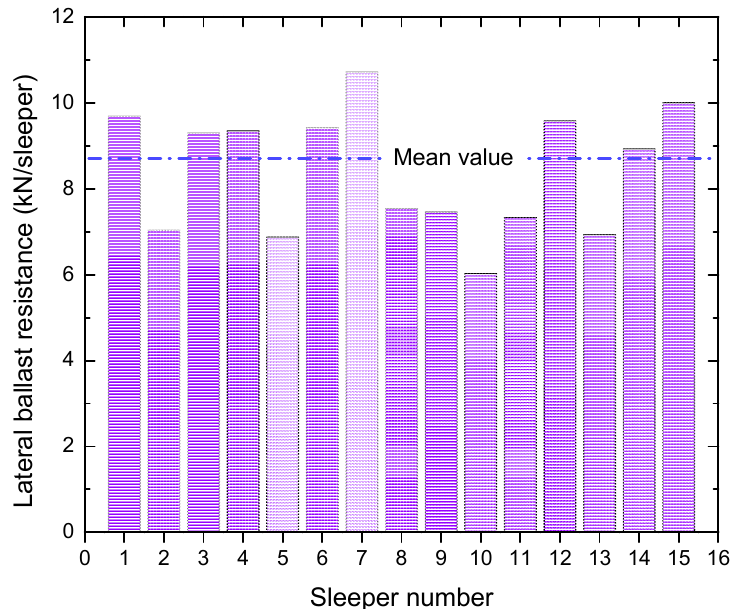
Figure 7. Distribution of lateral ballast resistance at 2 mm. The mean, variance, and standard deviation of the resulting values are 8.72, 2.49, and 1.58, respectively. The null hypothesis, H 0 , is that the overall distribution of the lateral ballast resistance samples follows a normal distribution. The test results, given a 5% level of significance, are shown in Table 1.